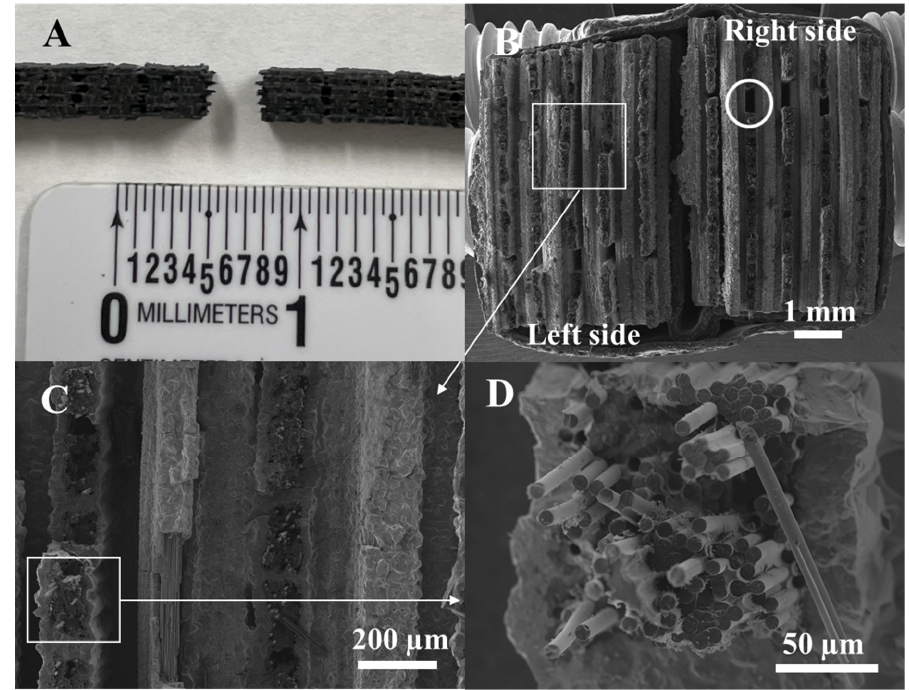
Figure 11. ( A ) Macro and ( B – D ) SEM images of fracture surfaces after four ‐ point bend